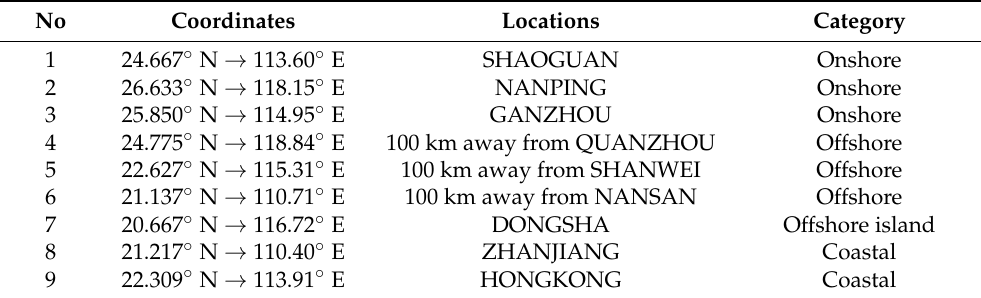
Table 1. Coordinates of the locations used in the